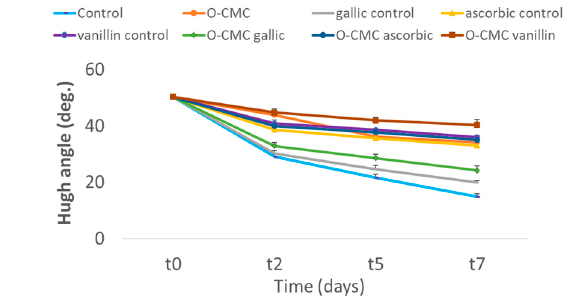
Figure 2. Fruit surface color parameters: a*, b*, L*, and Hue angle at different storage times of fresh-cut strawberries treated with oligo-CMC formulations as the means of three replicates.